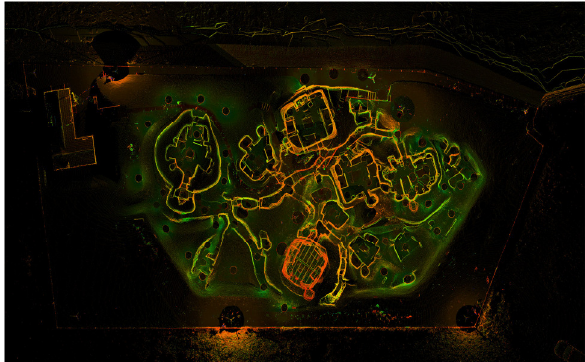
Figure 2. Point cloud showing plan view of Skara Brae village, coloured by intensity values © CDDV